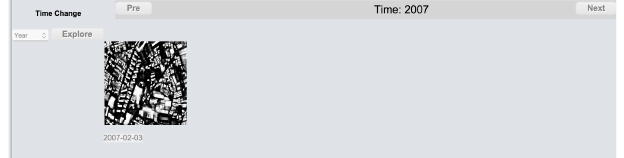
Figure 10. Temporal series information year 2007